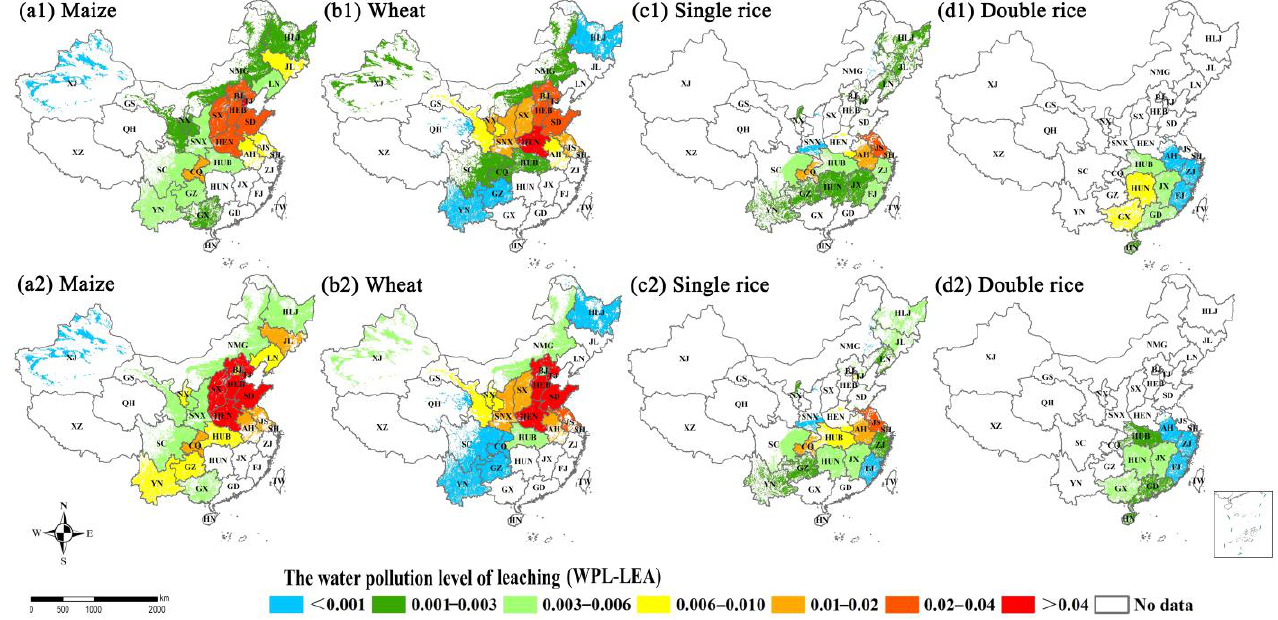
Figure 8. The water pollution level of leaching losses (WPL-LEA) between 2004 – 2008 and 2014 – 2018 for ( a1 , a2 ) maize, ( b1 , b2 ) wheat, ( c1 , c2 ) single rice and ( d1 , d2 ) double rice at provincial scale in China’s farmlands, respectively.